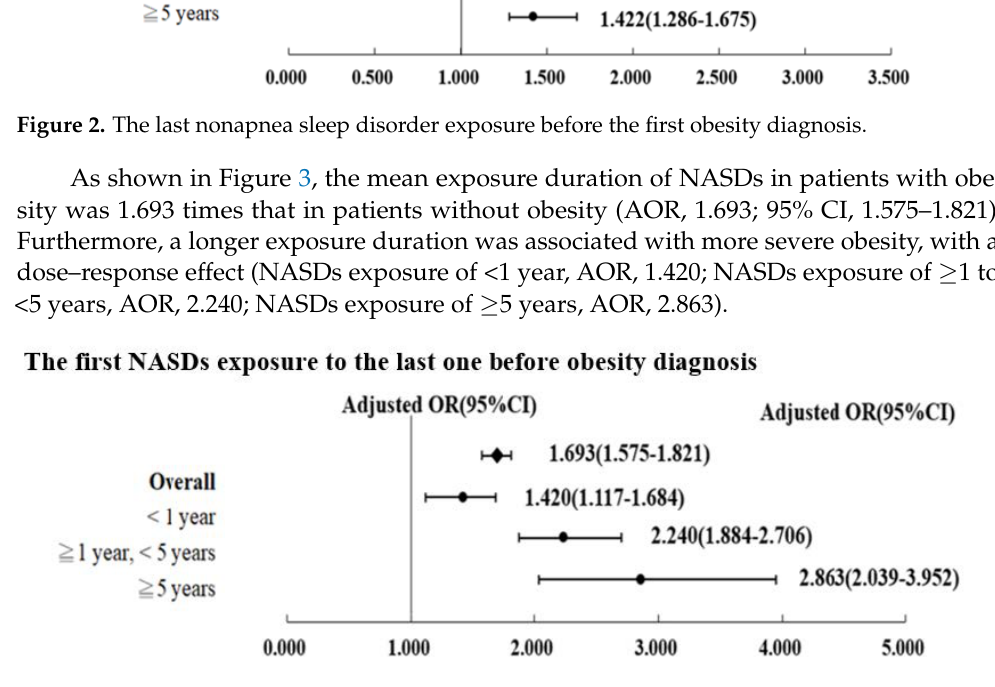
Figure 3. The first nonapnea sleep disorder exposure to the last one before obesity diagnosis.